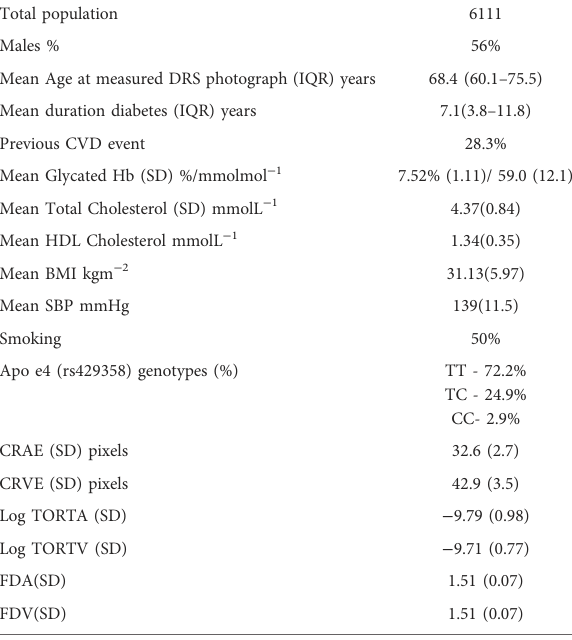
TABLE 1 Study population baseline